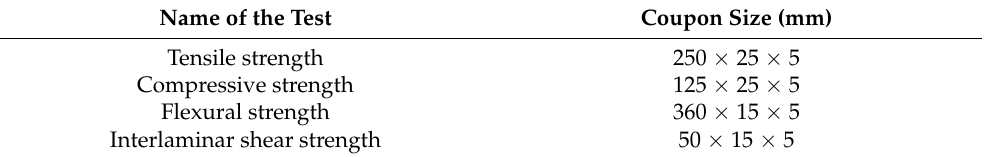
Table 1. Details of the GFRP